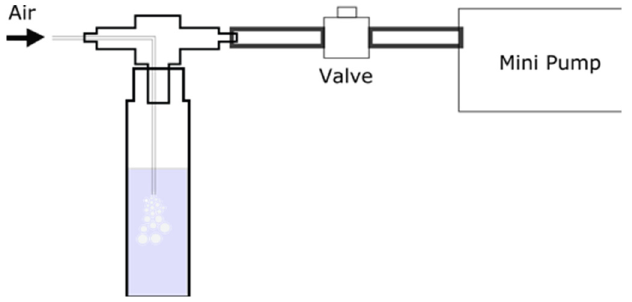
Figure 3. Atmospheric air sampling with constant air flow of 100 mL min − 1 .